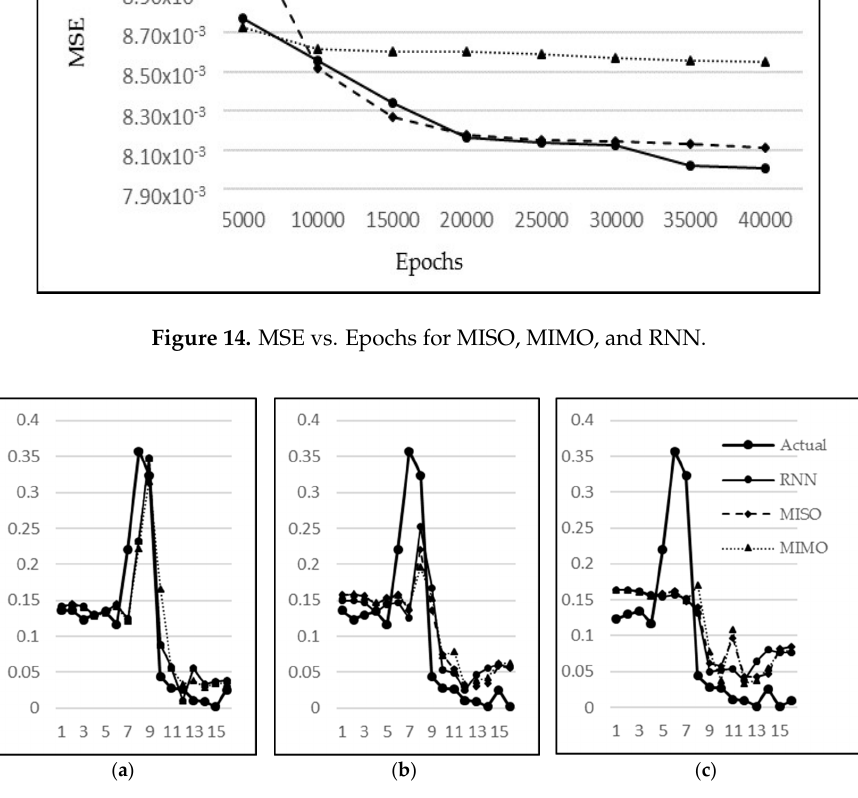
Figure 15. Actual vs. Predicted plot for ( a ) one-step-ahead forecasting; ( b ) two-step-ahead forecasting; and ( c ) three-step-ahead forecasting.